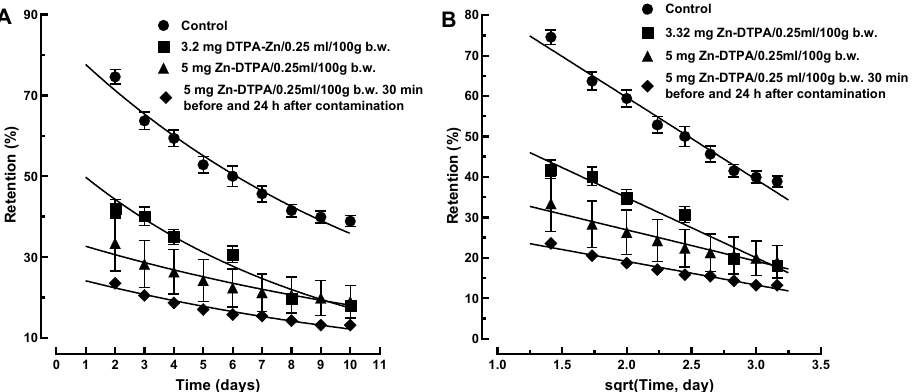
Figure 9. Comparison of the diffusional kinetics model and mono-phasic kinetics model for 65 Zn decorporation following rapid intervention with Zn-DTPA. ( A ) Mono-phasic exponential kinetics model of 65 Zn decorporation following rapid intervention with Zn-DTPA. ( B ) Square-root diffu- sional model of 65 Zn decorporation following rapid intervention with Zn-DTPA. Data represent means ± SEM ( n = 7).